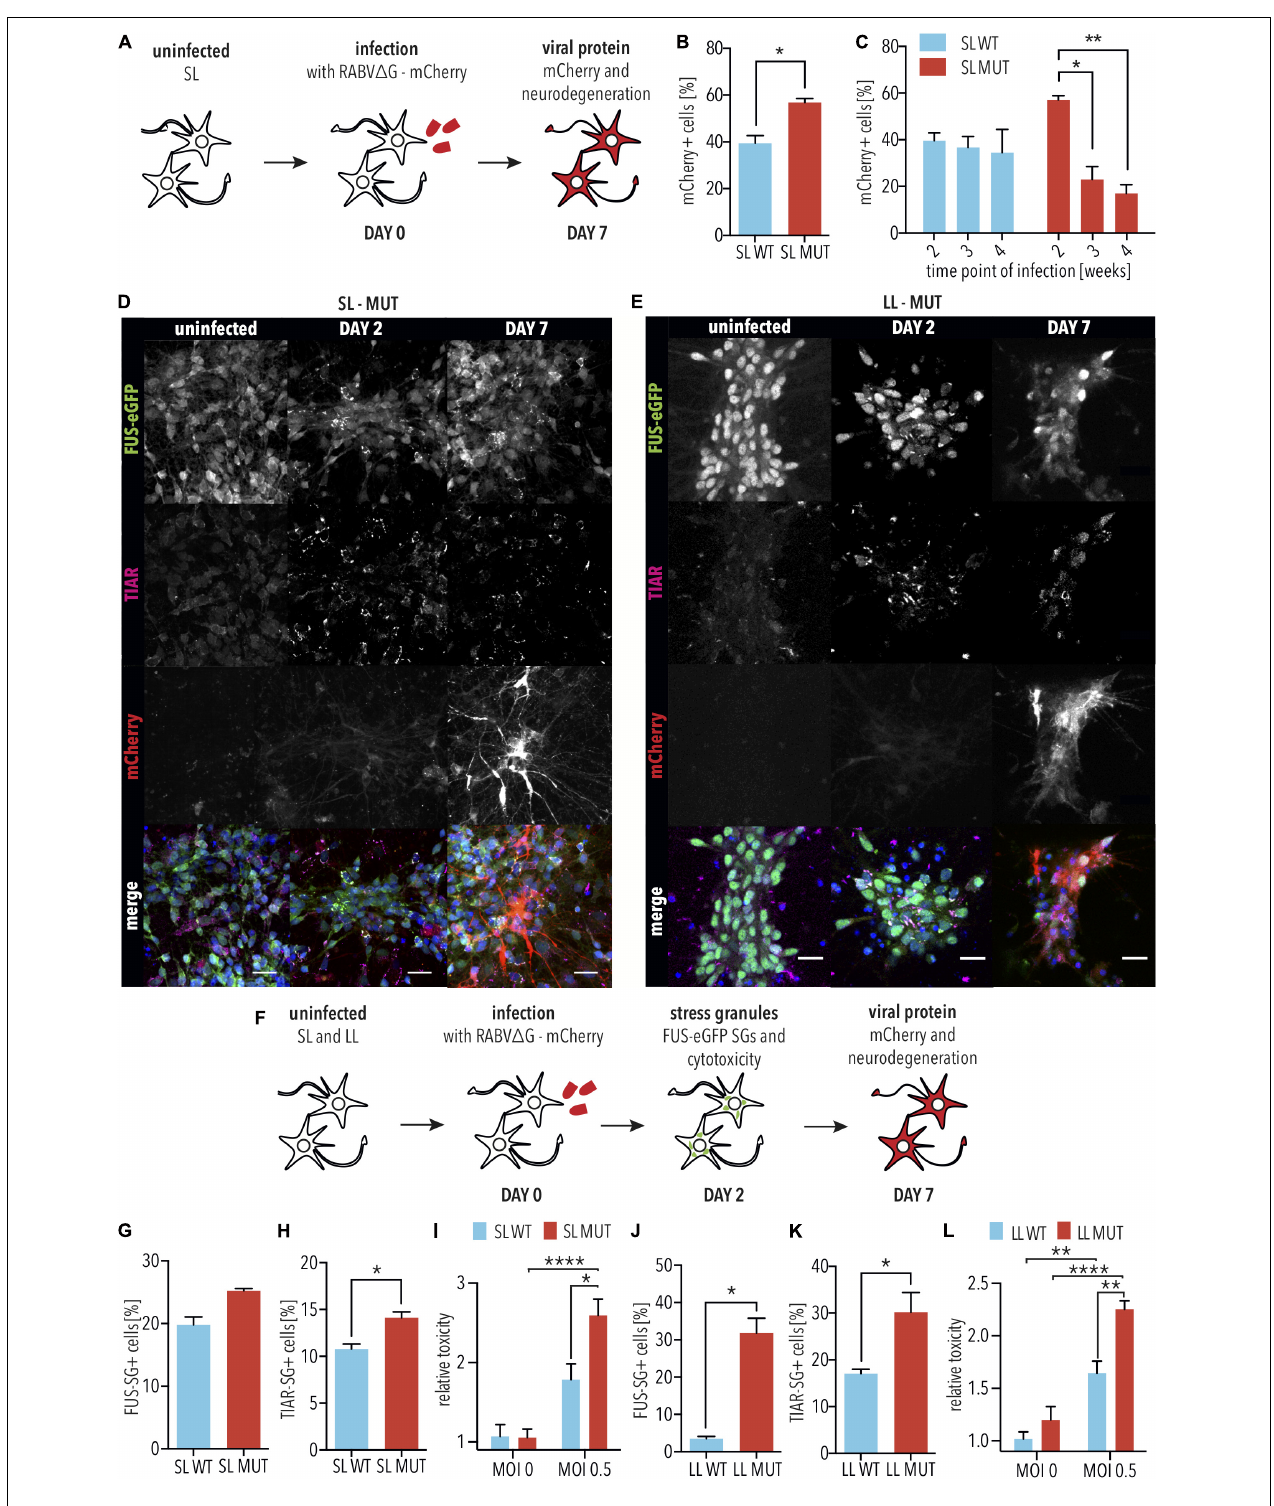
FIGURE 3 | FUS-P525L spinal neurons show neurodegeneration due to altered virus defense against RABV (cid:49) G. (A) Diagram illustrating infection of iPSC-derived spinal neurons using RABV (cid:49) G. (B) SL FUS-P525L (SL MUT) show increased expression of RABV (cid:49) G-mCherry relative to WT (SL WT). 2 weeks after plating, neurons were infected with RABV (cid:49) G. Cultures were analyzed 7 days following infection. n = 3. Error bars indicate SEM. ∗ corresponds to p < 0.05 according to unpaired 2-tailed t -Test. (C) Number of RABV (cid:49) G-mCherry positive spinal neurons with the indicated genotype on the indicated time following